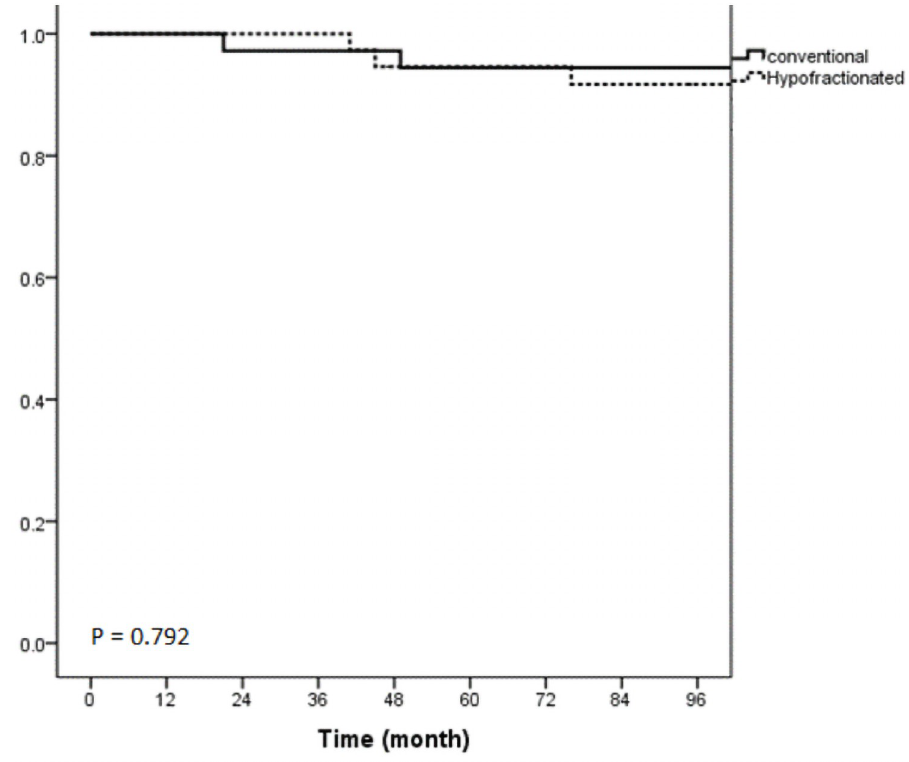
Fig 2. Kaplan-Meier curve of overall survival rate of both